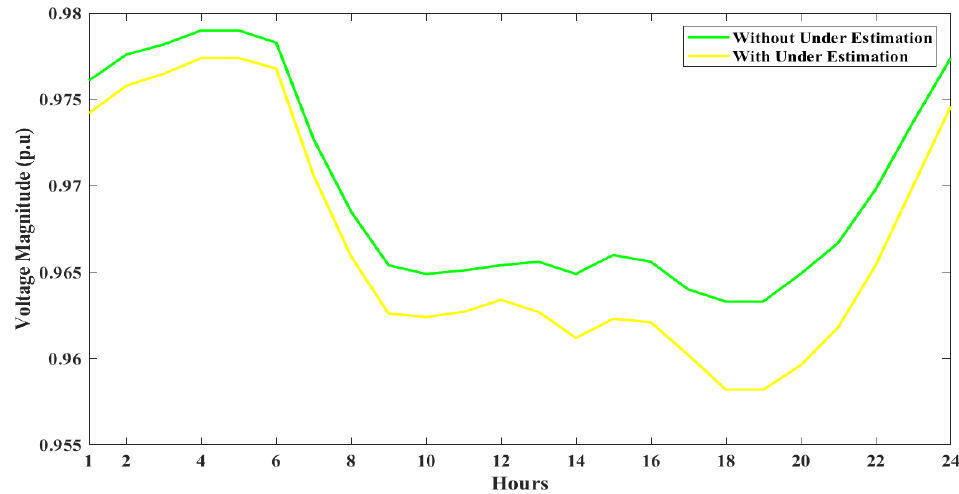
Figure 17. Voltage profile characteristic comparison with and without underestimation.